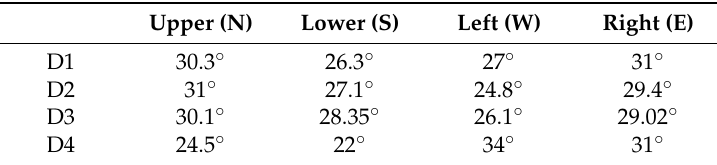
Table 6. Selected domains with their boundries in core of dust blume (D1 & D2), Qattara Depression (D3), and south west of Egypt